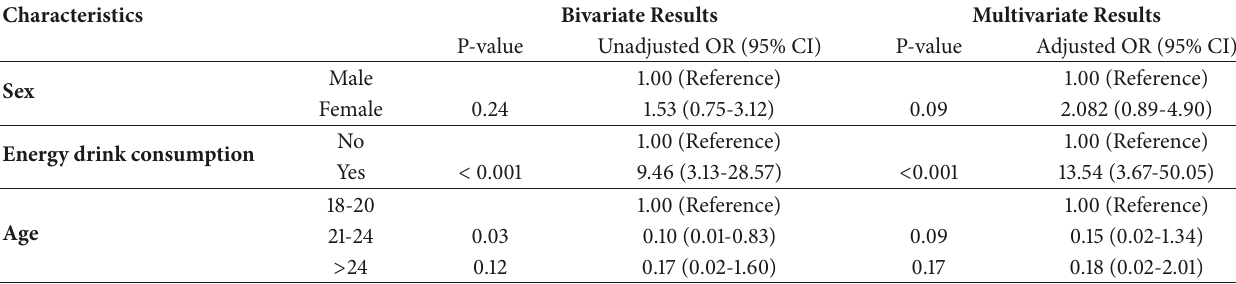
Table 3: Odds ratios for poor sleep quality according to PSQI.